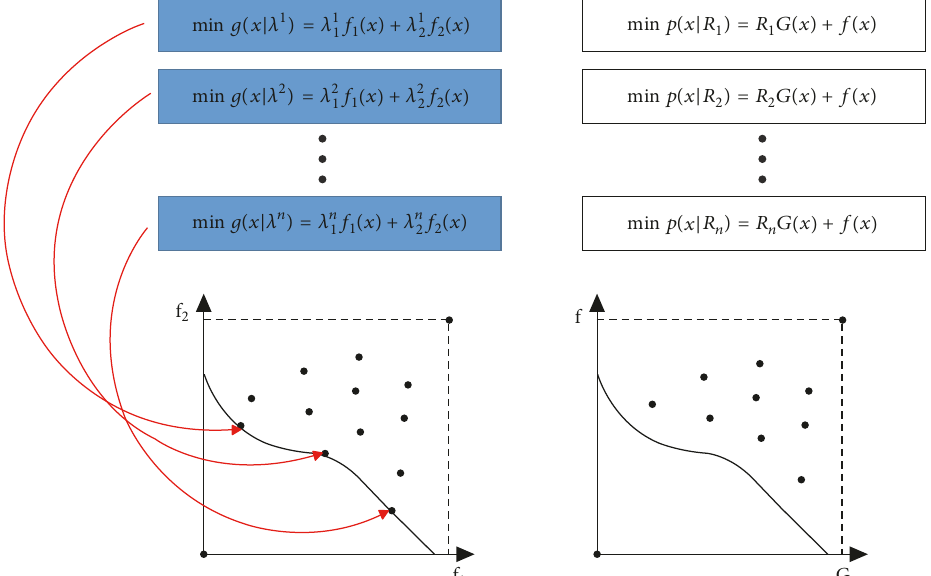
Figure 1: Mathematical association between decomposition approaches for multiobjective optimization and penalty function methods for constrained optimization.